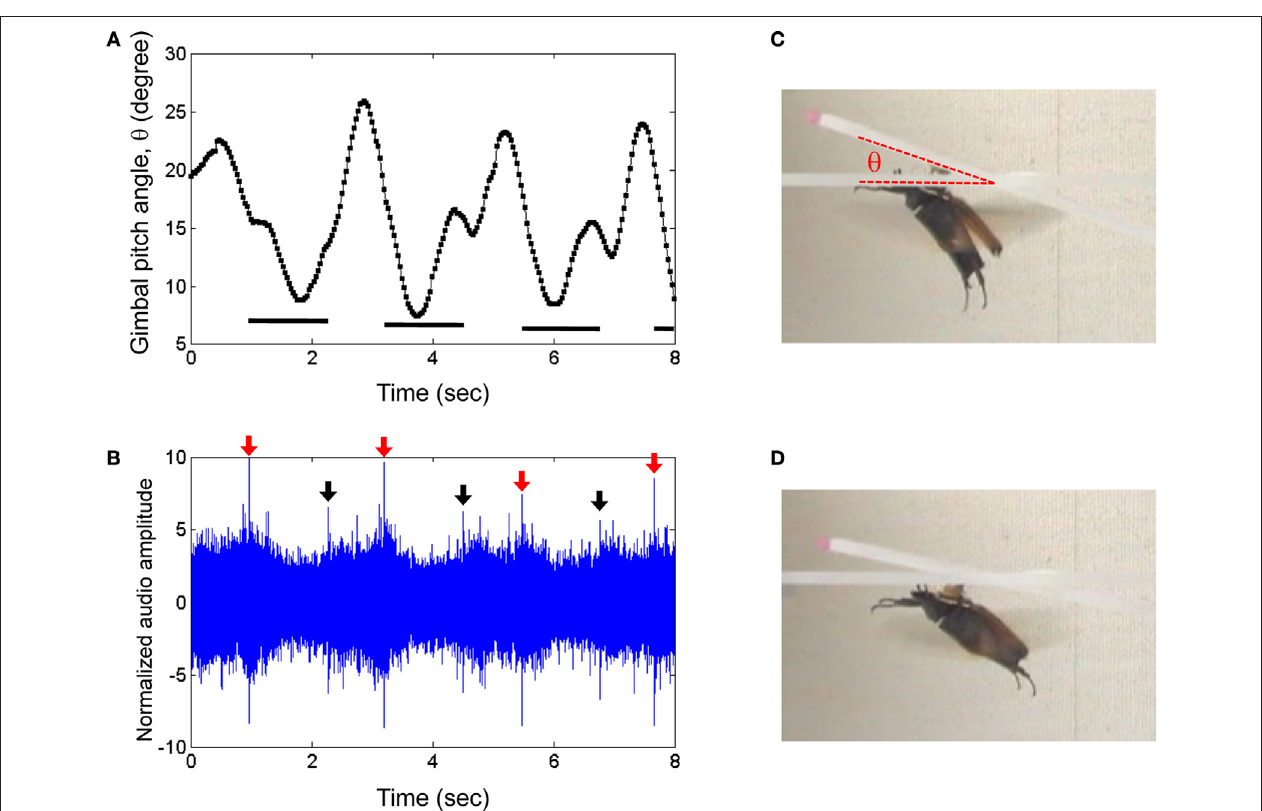
FIgure  | elevation control of a Mecynorrhina torquata beetle tethered on a custom pitching gimbal. Brain stimulus altered the gimbal pitch of the beetle (100 Hz, 2.0 V amplitude, see Figure 3A for waveform). (A) Gimbal pitch angle with the mounted beetle during alternating periods of un-stimulated and stimulated flight. Horizontal bars indicate durations of the stimuli. (B) Audio recording corresponding to (A) . Red and black arrows indicate beginnings and